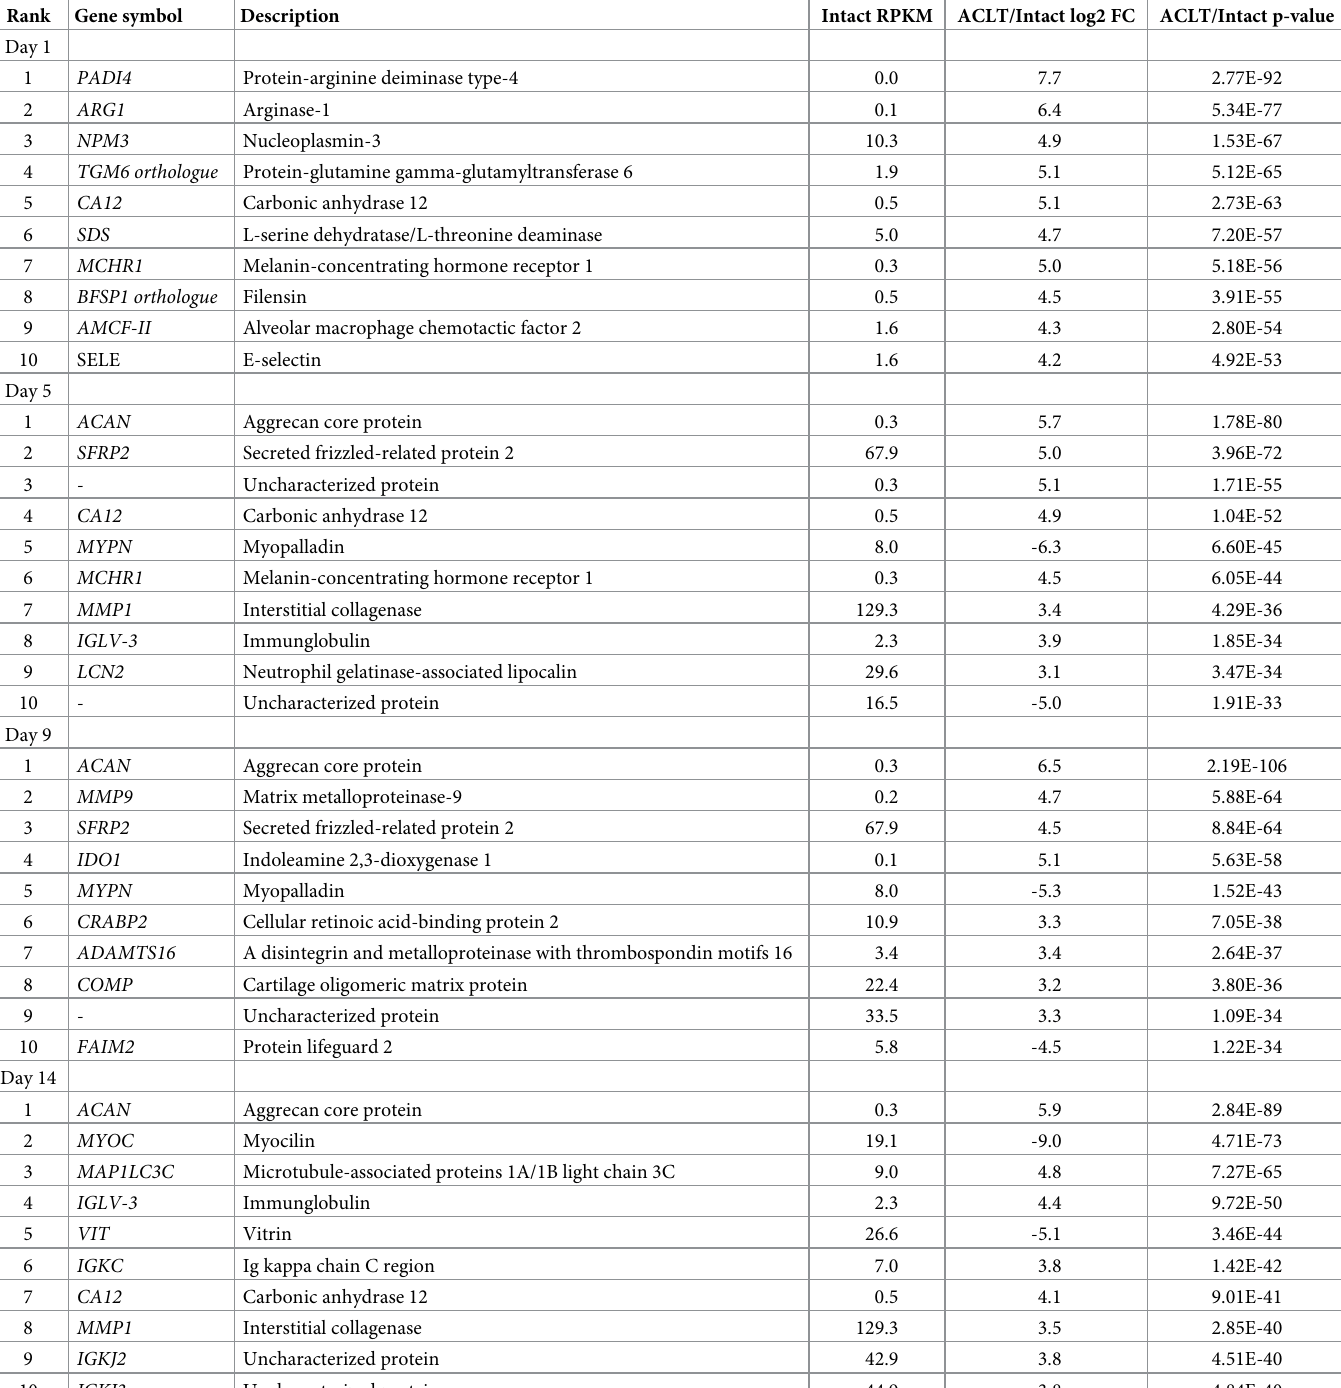
Table 1. Transcriptional response of synovium to joint